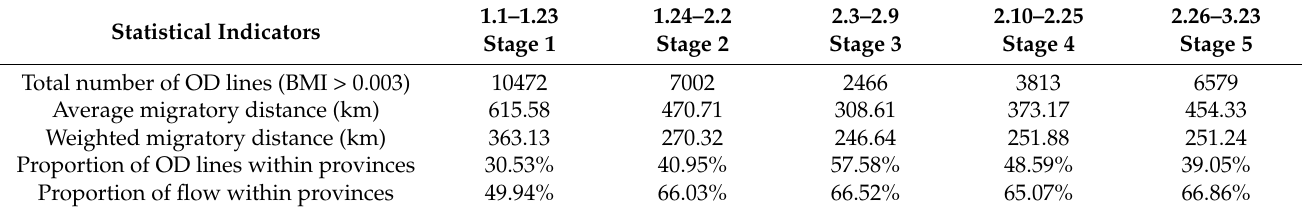
Table 1. Migration distance and proportion of migration within the province of